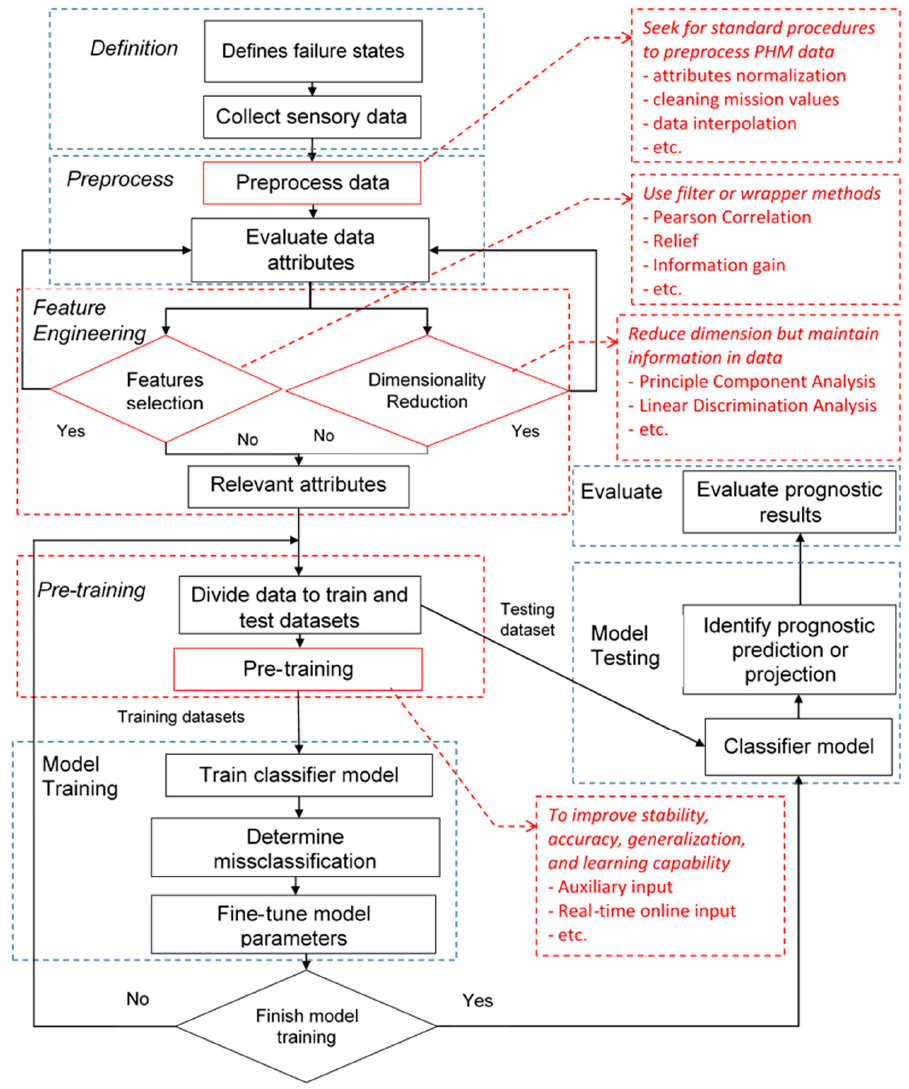
Figure 4. The prognostic data-driven framework for neural network algorithms.